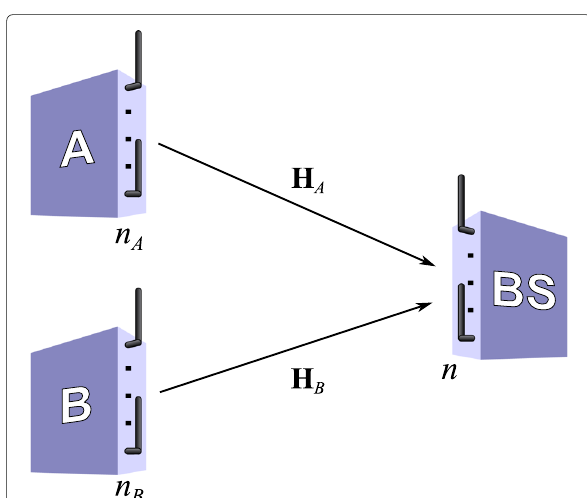
Fig. 1 System model of two-user MIMO MAC network. Mobile stations A and B have n i , i = A , B , transmitting antennas, respectively. The base station has n receiving antennas. The random channel gain matrix of each user is represented by H